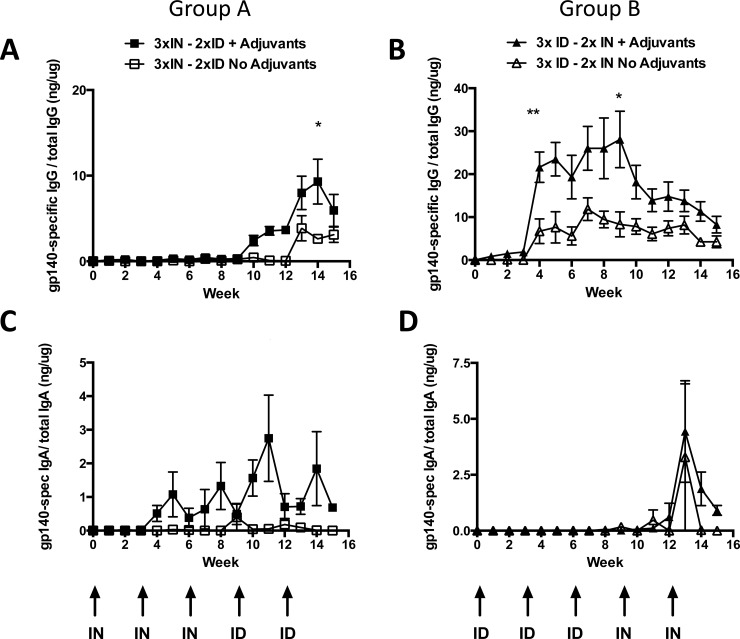
Combinations of R848 and/or GLA-AF administered by each route significantly enhance HIV Env gp140 antigen-specific vaginal mucosal immunoglobulin responses.A) Group A (3 × IN + 2 × ID) animals exhibited augmented vaginal mucosal IgG levels compared to animals that received the unadjuvanted vaccine (*p = 0.0167; week 14). B) Group B animals had higher vaginal mucosal IgG compared to animals that received the unadjuvanted vaccine (**p = 0.0069; week 4 and *p = 0.0247; week 9). C) IN inoculations elicited antigen-specific IgA that was boosted by a second and third IN application and by the first ID vaccination. D) ID vaccinations failed to elicit detectable vaginal IgA, subsequent IN inoculations generated very low levels of antigen-specific IgA.